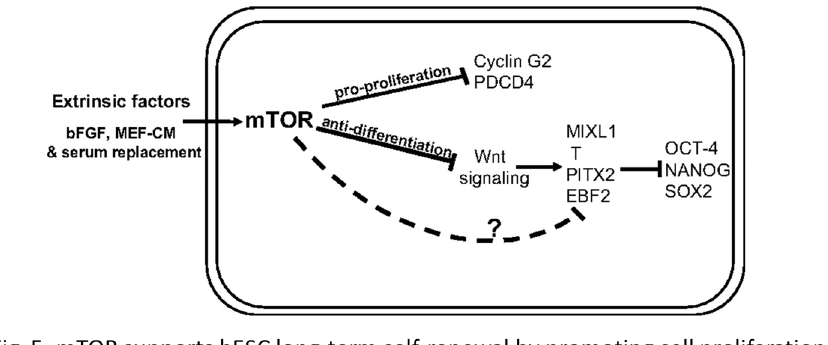
Figure 4. A model that appears in the article [ 21 ] as ‘‘Fig. 5’’. The author did not judge this model as the most important figure, while other authors judged models in their publications as the most important figure.